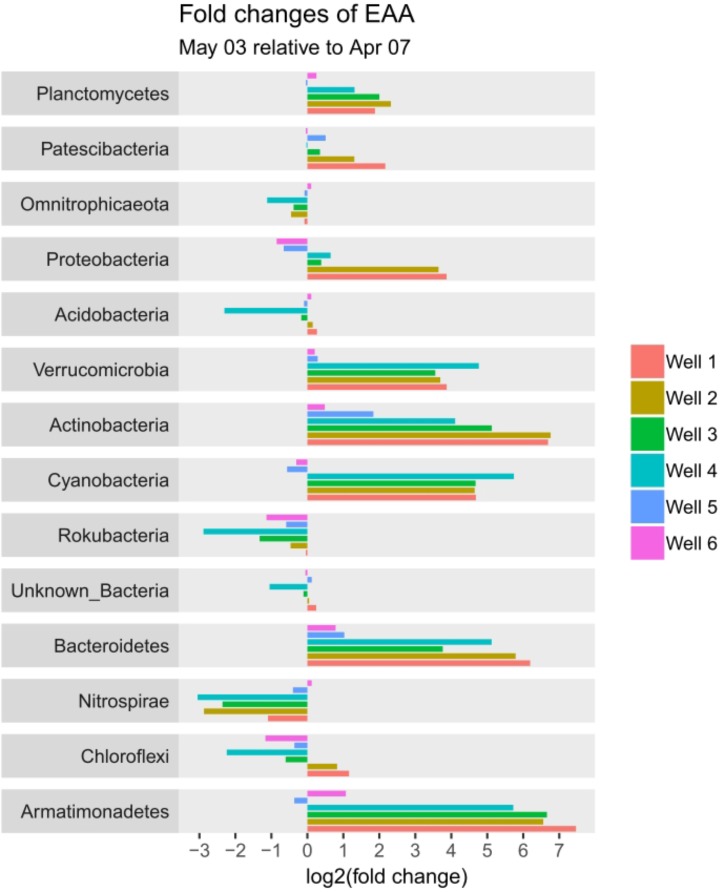
Fold-change plot of phyla from April 7 to May 3 based on estimated absolute abundances (EAA).